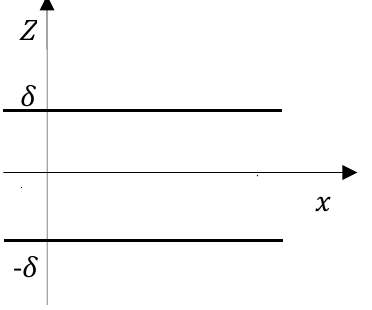
Figure 1. Schematic representation of the geometry.